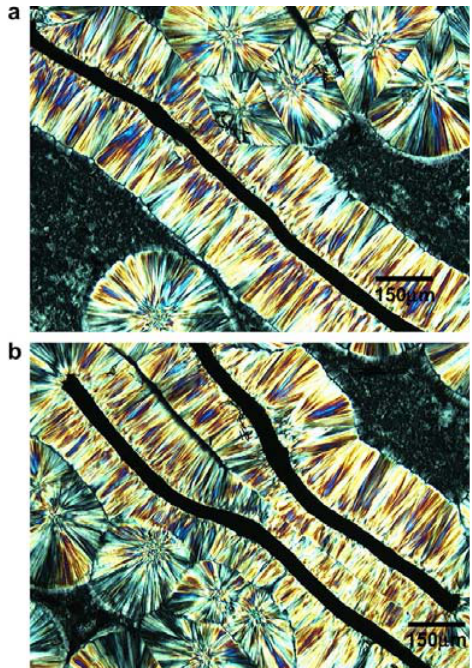
Figure 20. Optical micrographs of transcrystalline interphases for polypropylene surrounding the carbon fibers isothermally crystallized at 125 °C: (a) a single carbon fiber and (b) two carbon fibers. Reproduced with permission from ref.